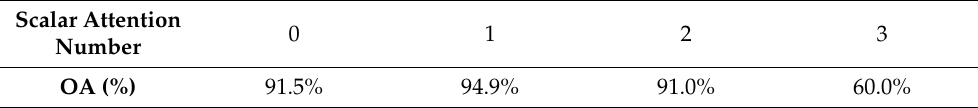
Table 3. Effect of scalar attention number.